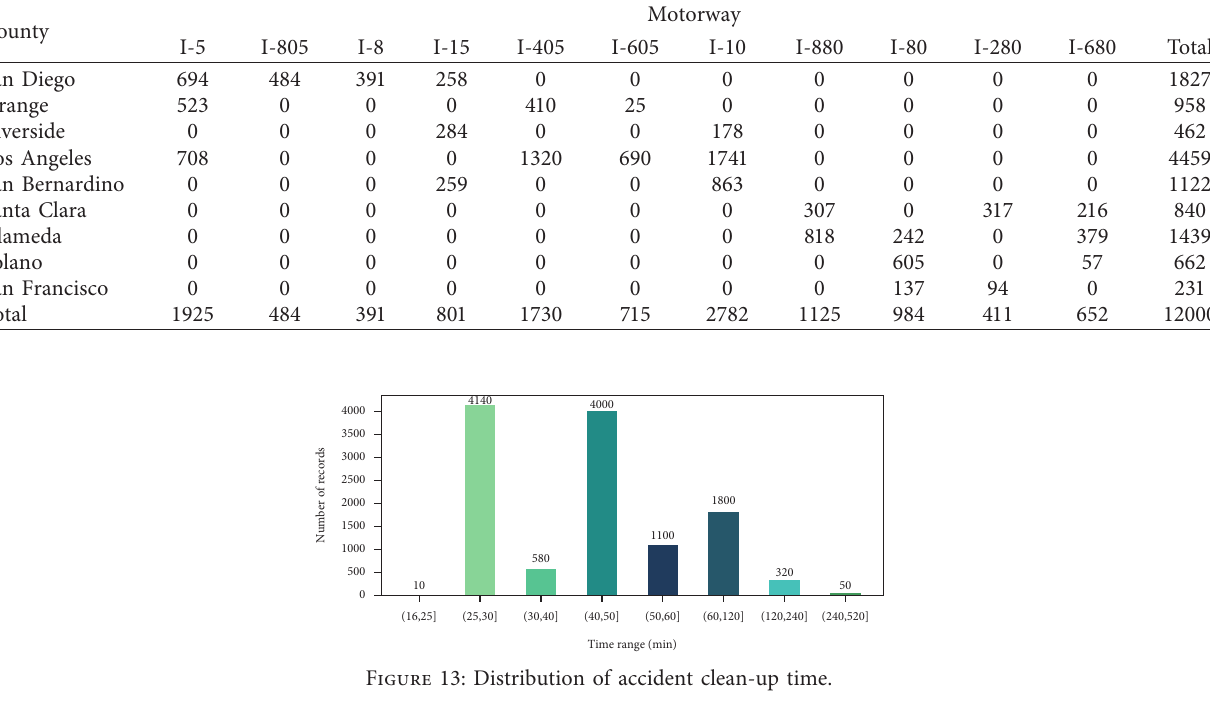
Table 3: Locations of traffic accident records.